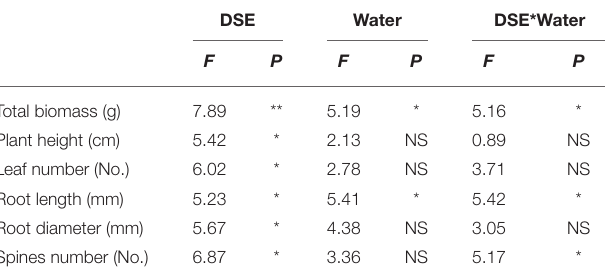
FIGURE 1 | Colonization rates of dark septate endophytes (DSE) in the roots of Lycium ruthenicum . (A) hyphal colonization; (B) microsclerotial colonization; (C) total colonization. AC, Alternaria chlamydospore ; NP, Neocamarosporium phragmitis ; MA, Microascus alveolaris ; WW, well-watered; DS, drought stress, respectively. The a, b letters indicate significant difference at P < 0.05 by Duncan’s multiple-range tests. segments was treated with 10% (w/v) KOH solution (100 ◦ C, 1 h), TABLE 2 | Two-way ANOVA of the effect of DSE and water condition on plant growth parameters of Lycium ruthenicum and stained with 0.5% (w/v) acid fuchsine (90 ◦ C, 20 min). Fifty